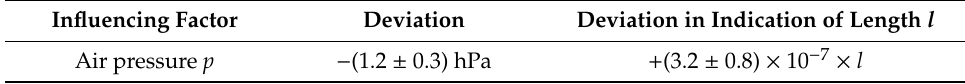
Table 8. Example of a calibration result of an air pressure sensor and the e ff ect on a measured length. Influencing